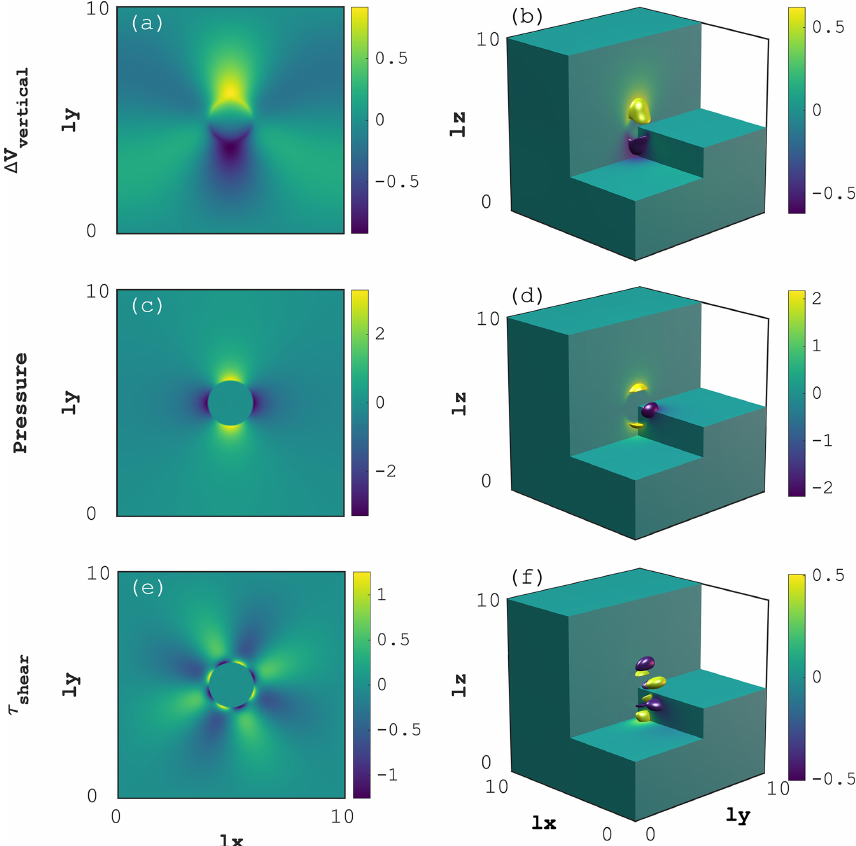
Figure 8. Model output for the 2D (a, c, e) and 3D (b, d, f) visco-elastic Stokes flow containing an inclusion featuring a viscosity contrast ( µ 0 /µ i = 10 3 ). The upper (a–b) , centre (c–d) , and lower (e–f) panels depict the deviation from background vertical velocity (cid:49)V vertical , the dynamic pressure P and deviatoric shear stress τ shear ( τ xy in 2D, τ xz in 3D) distribution,